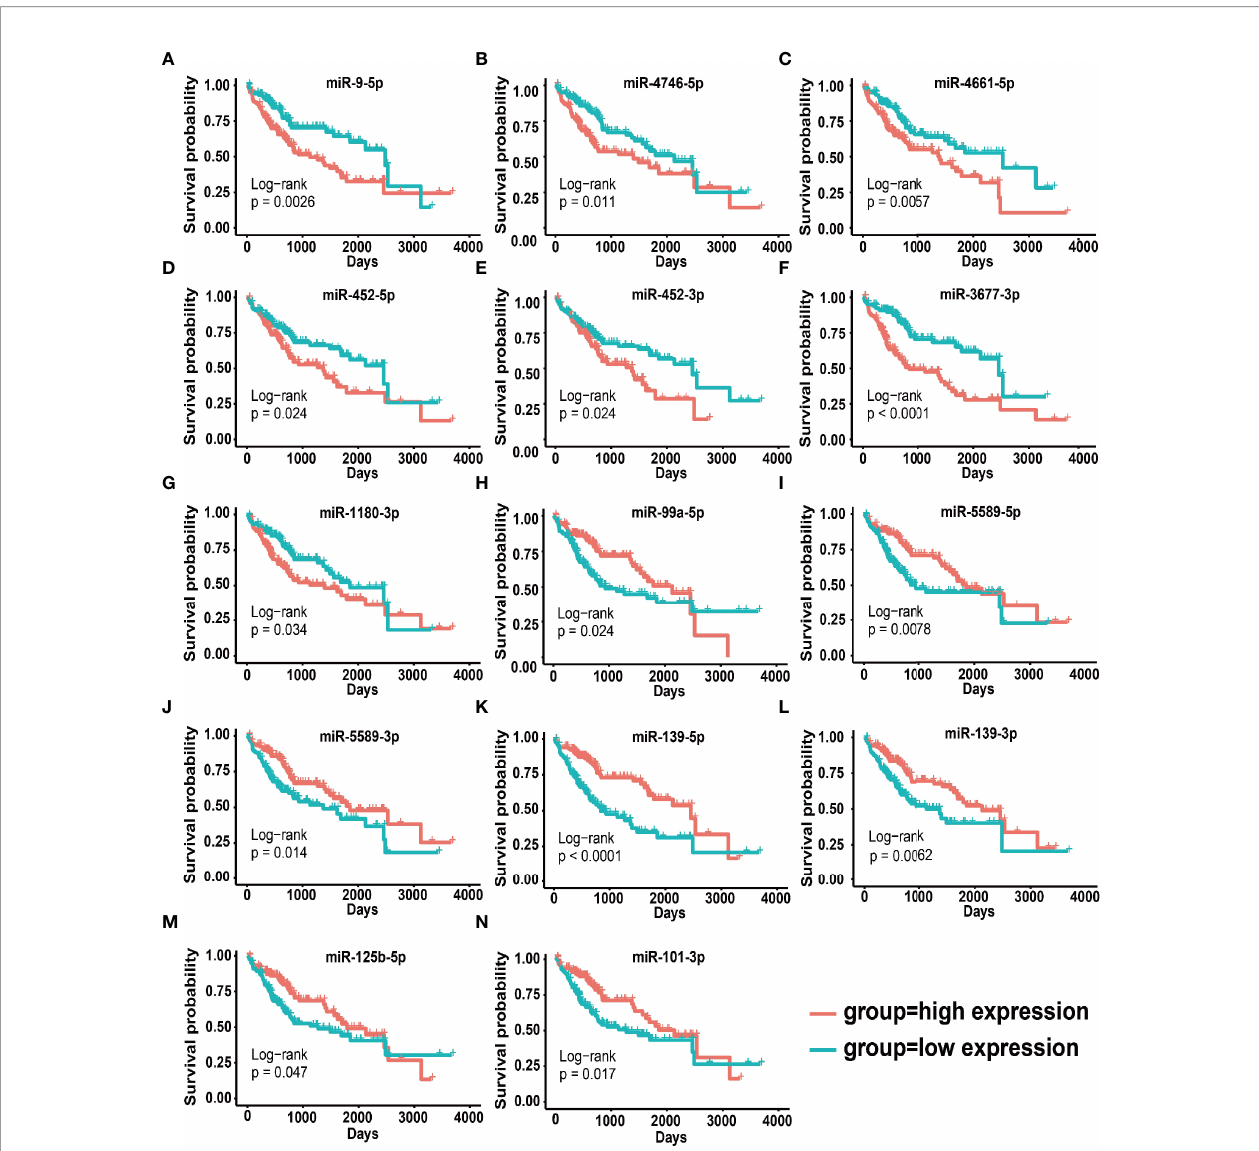
FIGURE 2 | Survival curves for 14 prognostic miRNAs. (A – H) Survival curves of seven up-regulated oncogenic miRNAs. (I – N) Survival curves of seven down- regulated cancer suppressor